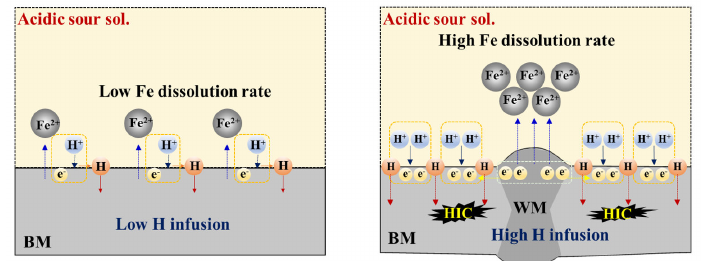
Figure 5. Brief schematic illustration showing the mechanism of galvanic corrosion between the WM and BM, and hydrogen infusion and cracking in the